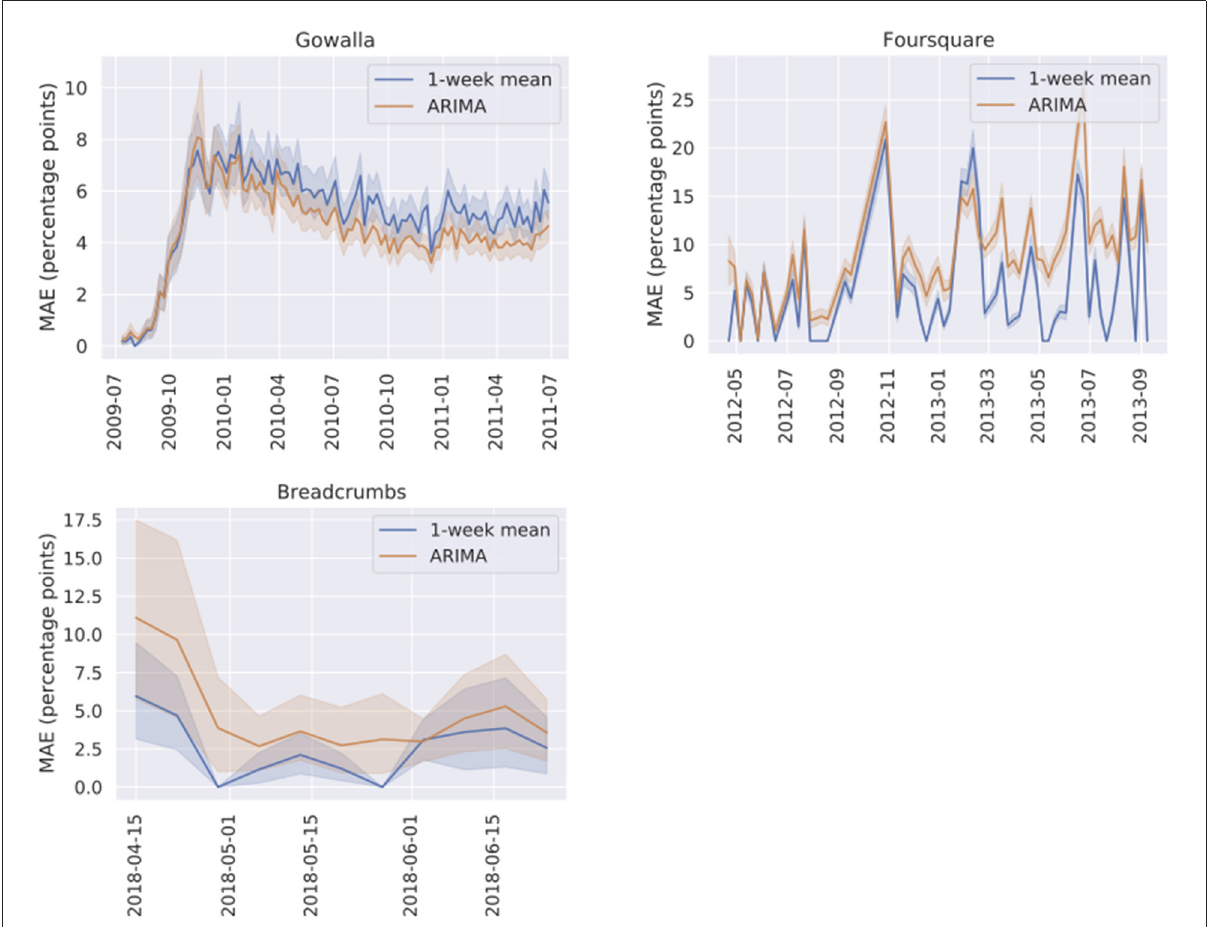
FIGURE8 Weekly Mean Absolute Error (MAE in percentage points) for predicting next-week’s cohort ratios in each of the three datasets (Gowalla, Foursquare and Breadcrumbs) using ARIMA predictor and simple 1-week mean predictor. The MAE numbers are averaged for all POIs in one dataset. The shaded areas represent 95% confidence